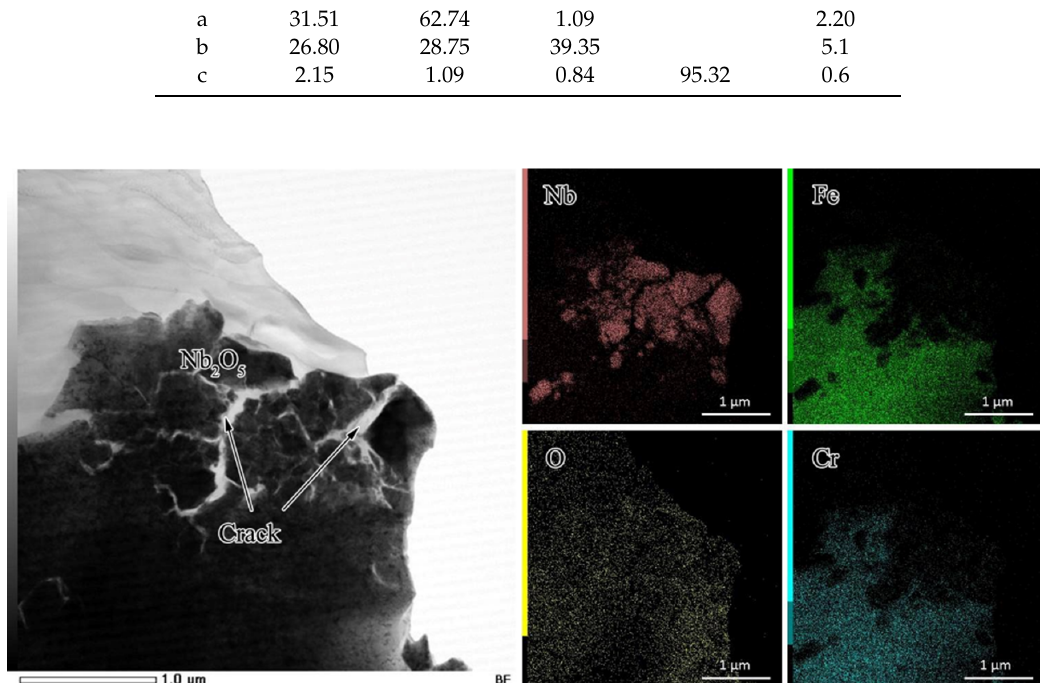
Figure 7. Transmission electron microscope (TEM) microstructures and elemental mappings of the oxide scale on the 2#HR3C alloy after oxidation in pure water vapor at 650 °C for 1000 h.